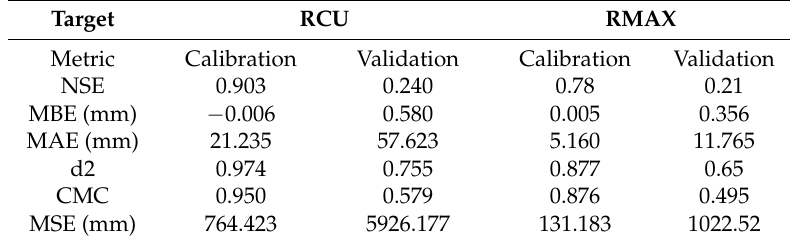
Table 6. Performance of the ANN model with the best structure for the simulation of rainfall as